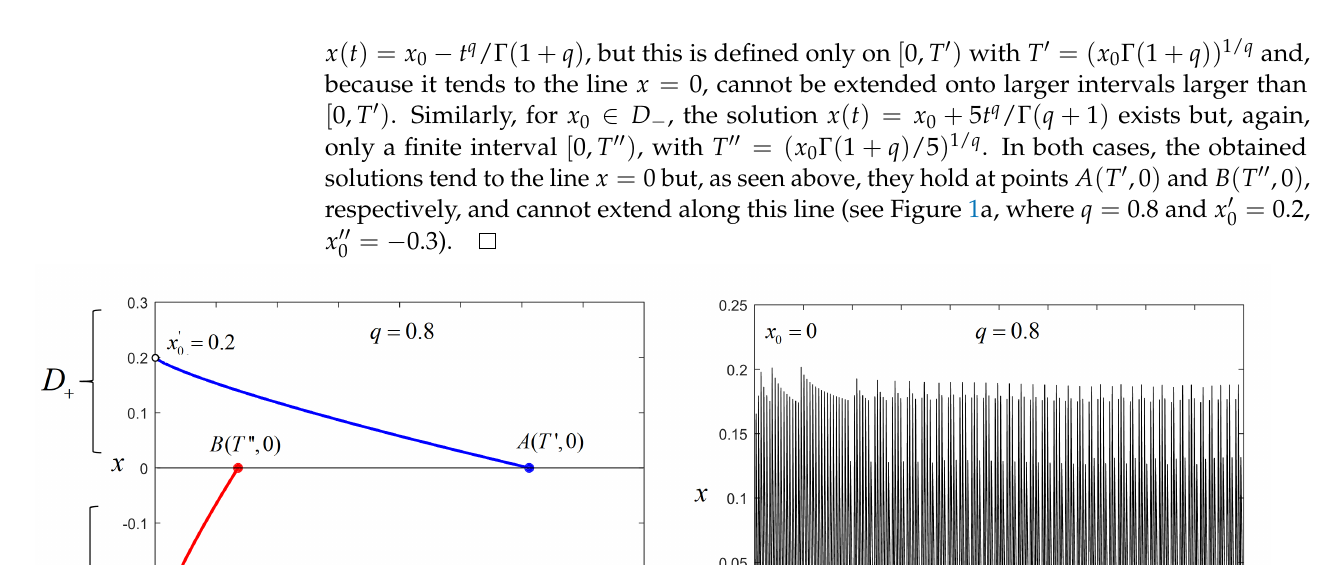
Figure 1. Equation (1); ( a ) Solutions for q = 0.8, and x (cid:48) tions are defined only for t ∈ [ 0, T (cid:48) ) and t ∈ [ 0, T (cid:48)(cid:48) ) , respectively; ( b ) Incorrect solution obtained by solving numerically the not-approximated PWC